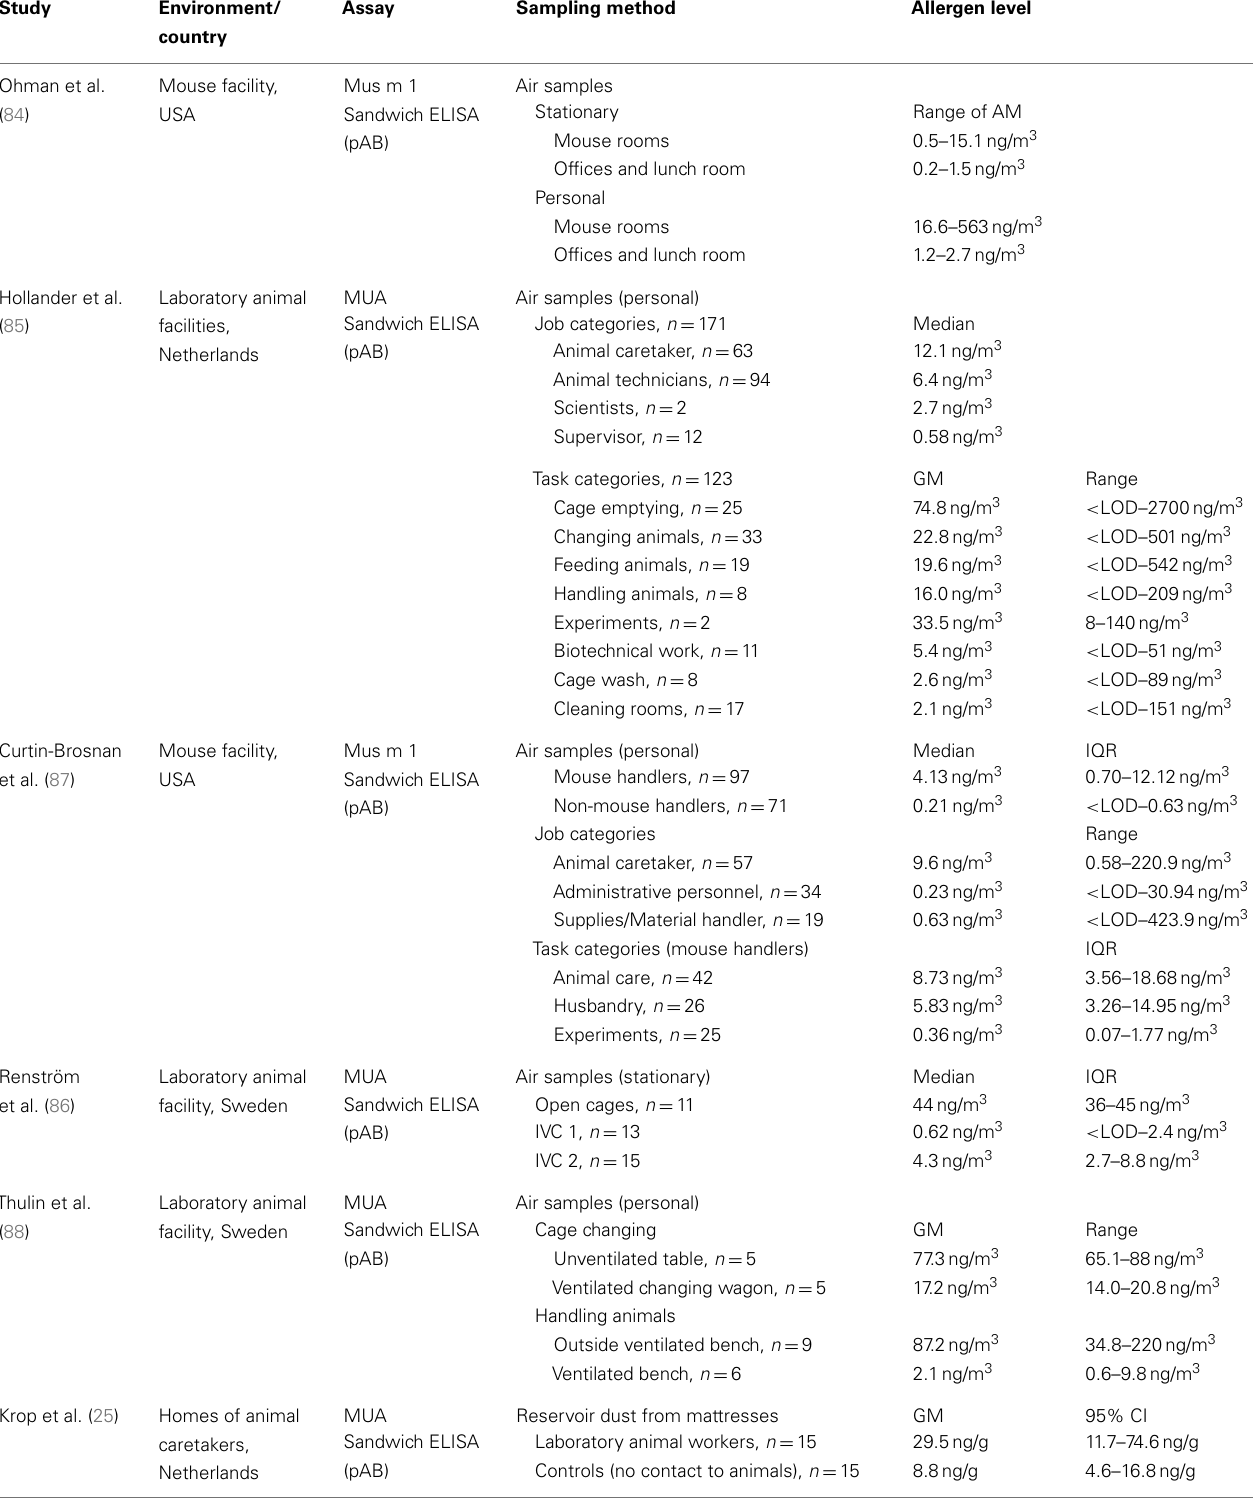
Table 3 | Studies related to exposure assessment to mouse